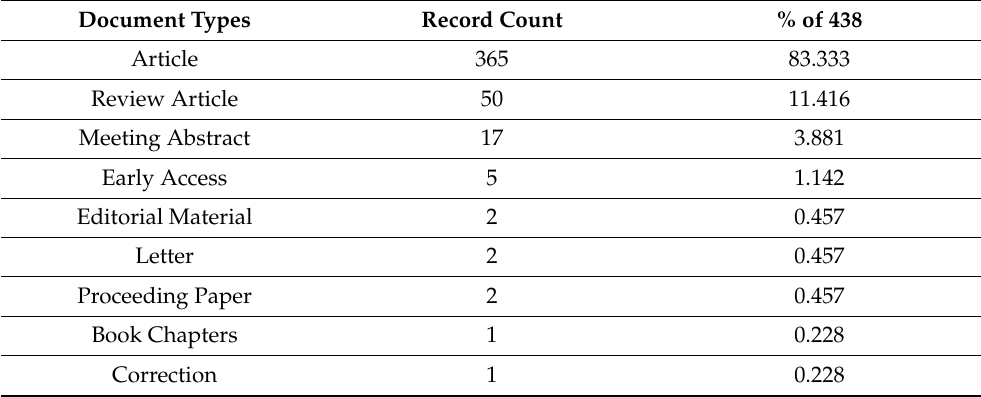
Table 1. Types and number of documents in prenatal exposure to air pollution